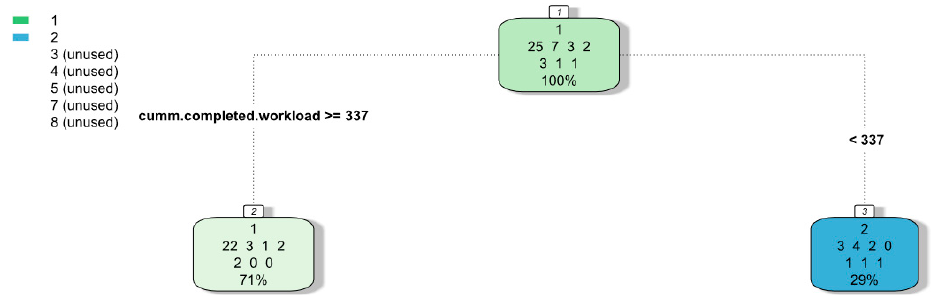
Figure 5. BPIC 17—classification tree indicating factors driving degree of non-linearity (edf).